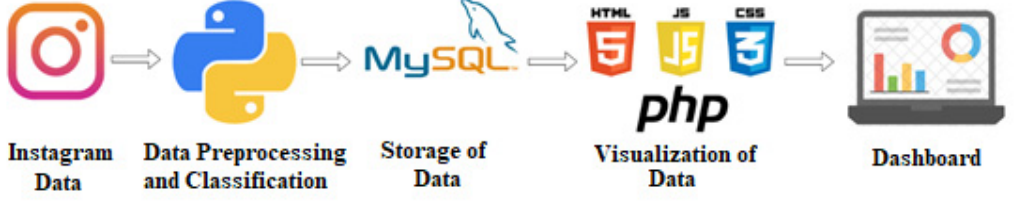
Figure 2. Application development process.